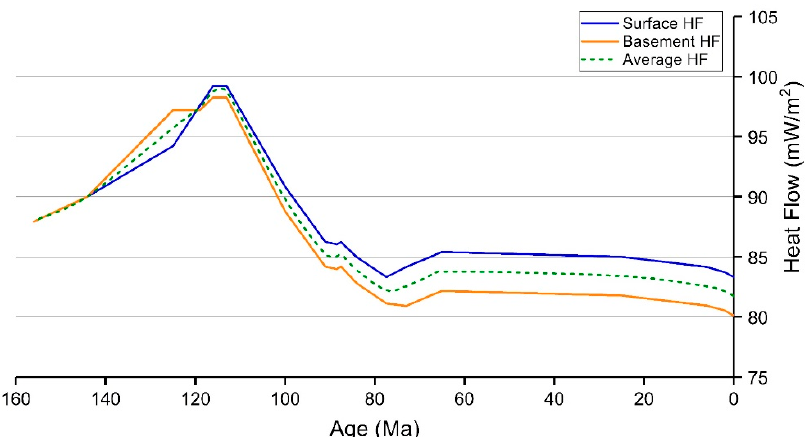
Figure 8. General heat flow (HF) history that was calculated from the surface HF and basement HF of the Songliao Basin based on the research of Li, 1995 [83].